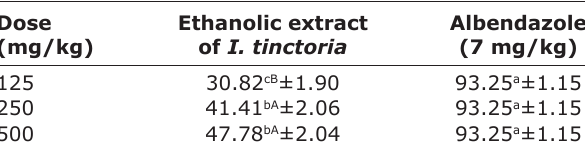
Table-2: Effect of I. tinctoria ethanolic extracton percent FECR (mean±SE) in sheep naturally infected with GI nematodes.